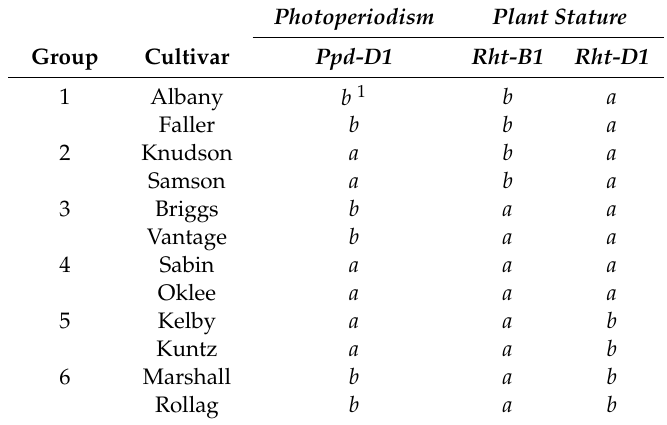
Table 2. Background genetic details of hard red spring wheat (HRSW)